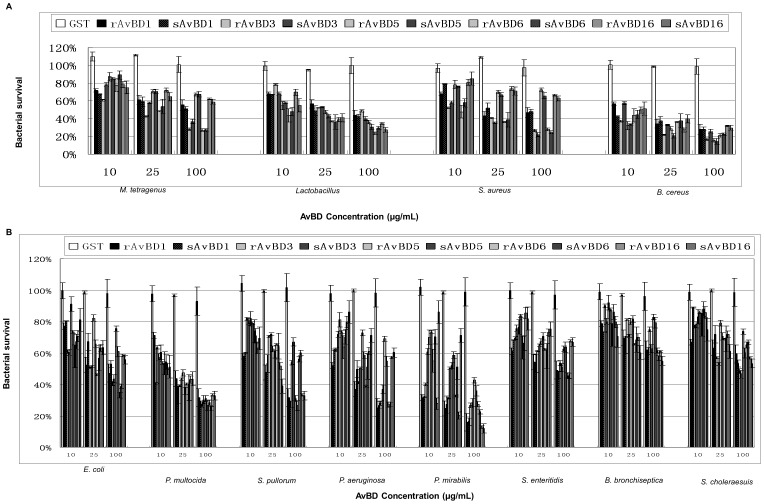
Antimicrobial activity of glutathione-S-transferase (GST), recombinant Apl_avian β-defensins (r Apl_AvBDs), and respective synthetic Apl_AvBDs (sApl_AvBDs) against bacteria.(A) Gram-positive bacteria; (B) Gram-negative bacteria. Bactericidal activity was calculated as the percentage of colony counts of bacteria not exposed to antimicrobial peptides but subjected to the same experimental conditions. All studies were performed in three independent experiments with three replicates per experiment, and each bar represents the mean ± SD. The data were analyzed using SAS [24].